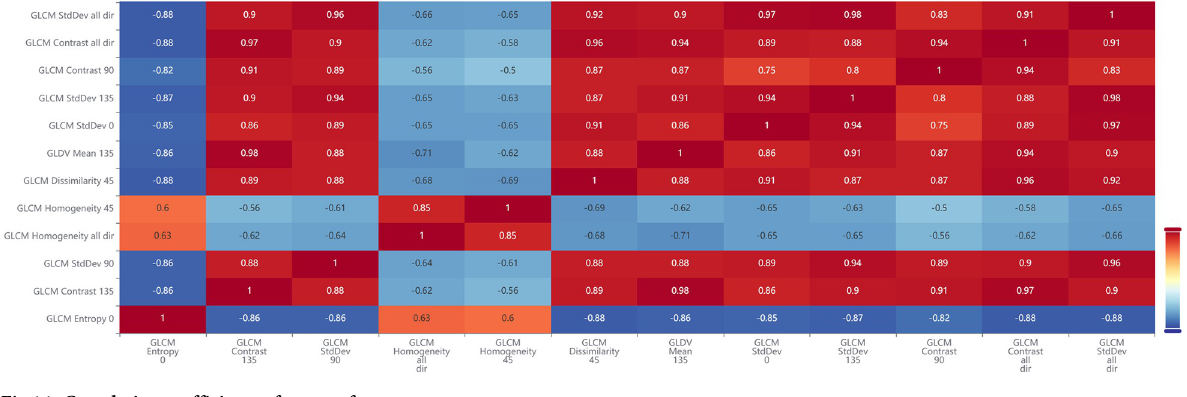
Fig 14. Correlation coefficients of texture features.